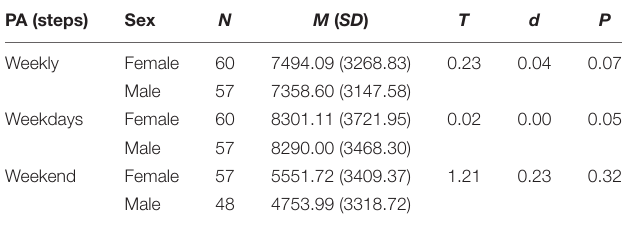
TABLE 2 | Physical activity (PA) comparison between male and female subjects.